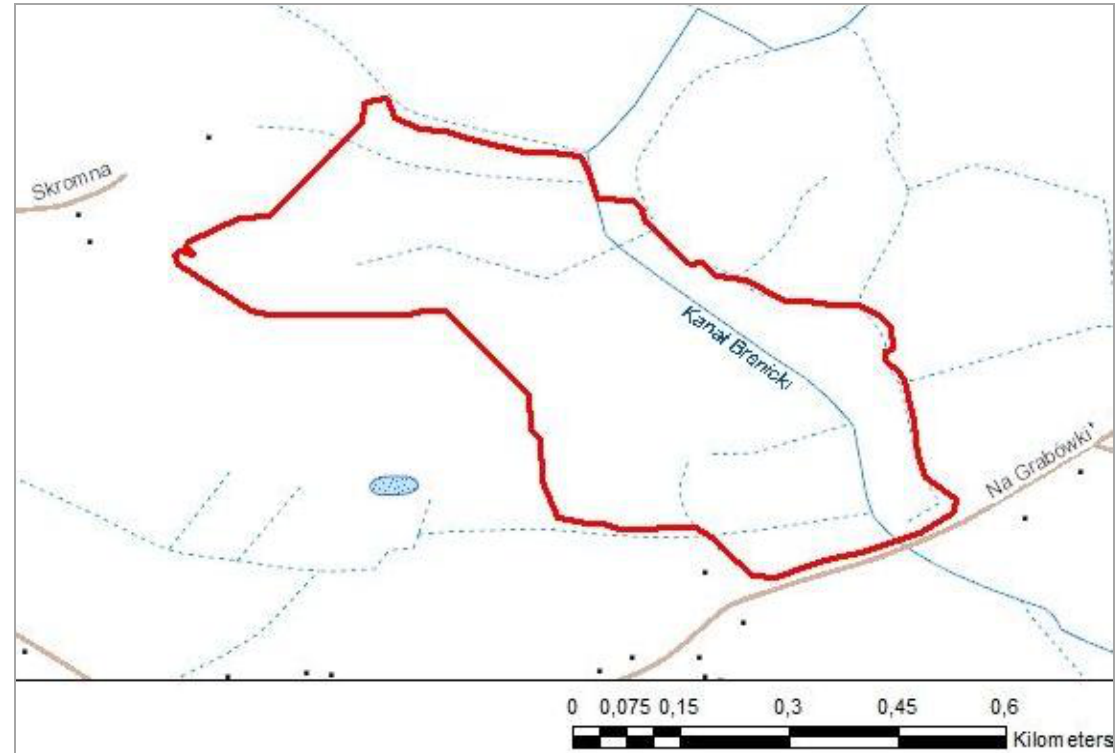
Fig. 1. Sketch-map showing the area of the reclaimed flooded mining pit (source: WMS